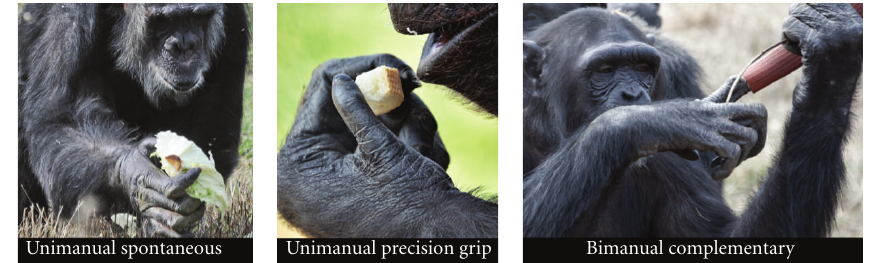
Figure 1: Di ff erent tasks performed by some of the chimpanzees at Fundaci´o Mona (Girona, Spain): unimanual spontaneous task, unimanual with precision grip (simple reaching), and bimanual complementary task (hose task) with tool use. (Credit: Miquel